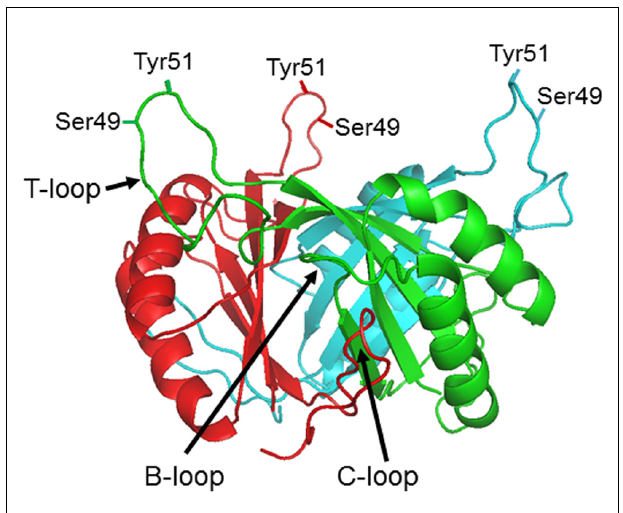
FIGURE 1 | P II protein structure . Side view of the Escherichia coli GlnB trimer (PDB: 2P II ) in the absence of ligands showing the positions of the B, C, andT loops and the residues within theT-loop (Ser49 andTyr51) which can be subject to post-translational modification in different